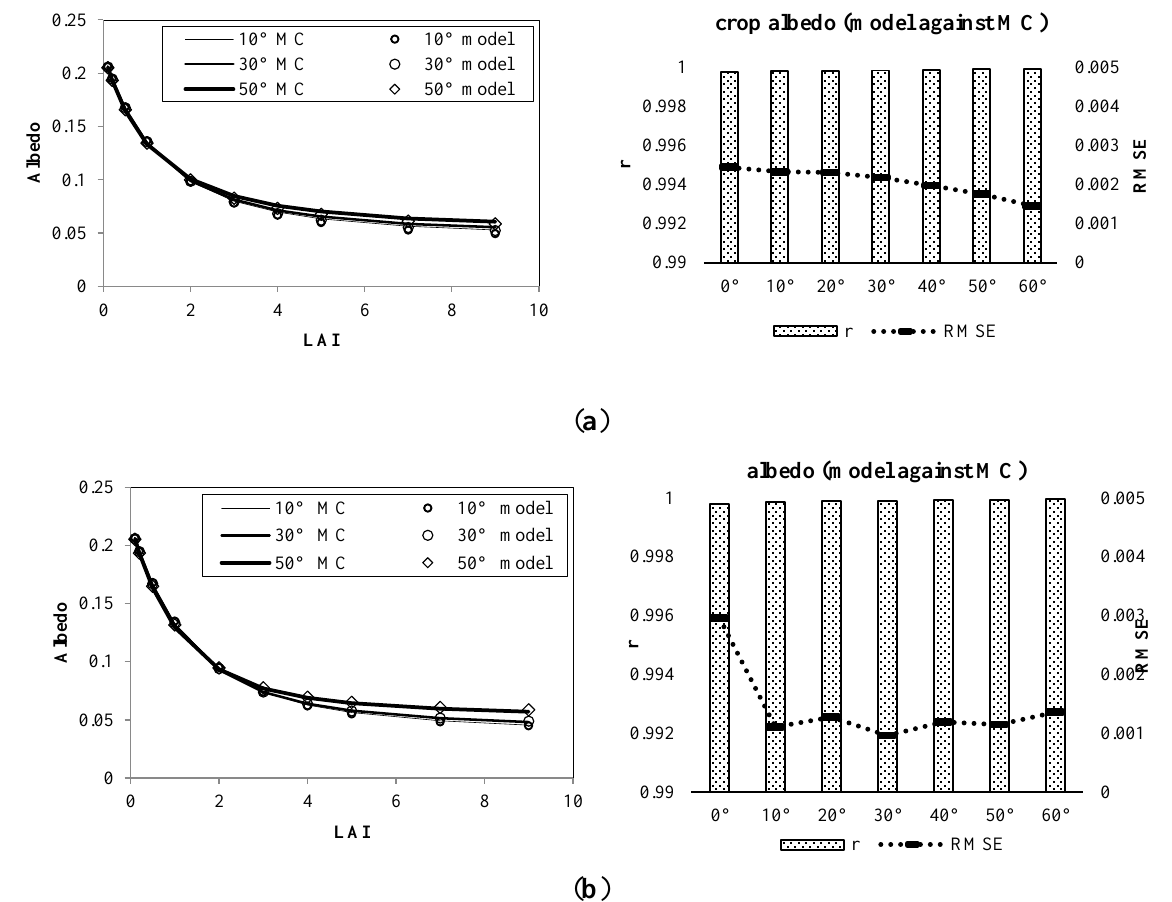
Figure 14. Relationships between LAI and crop albedo as predicted by the model (circles and diamonds) and MC (lines) under different solar zenith angles at the green band 0  ( a ) and 90  ( b